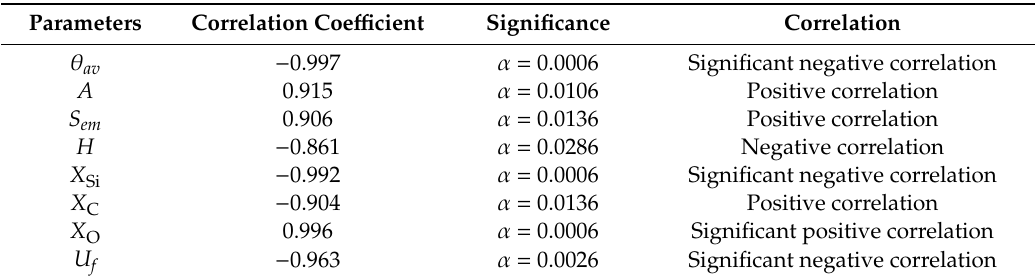
Table 9. Correlation between lifespan prediction parameters and aging time.